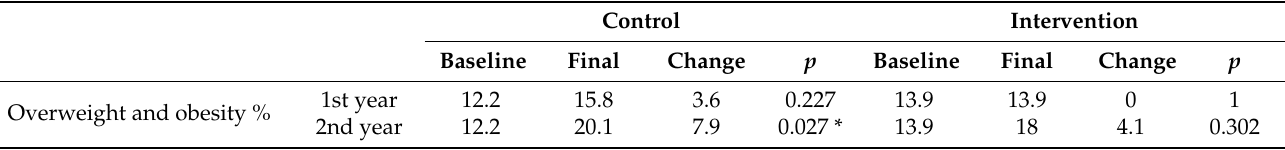
Table 4. Evolution of the prevalence of overweight and obesity in the participants of the control and intervention groups during the